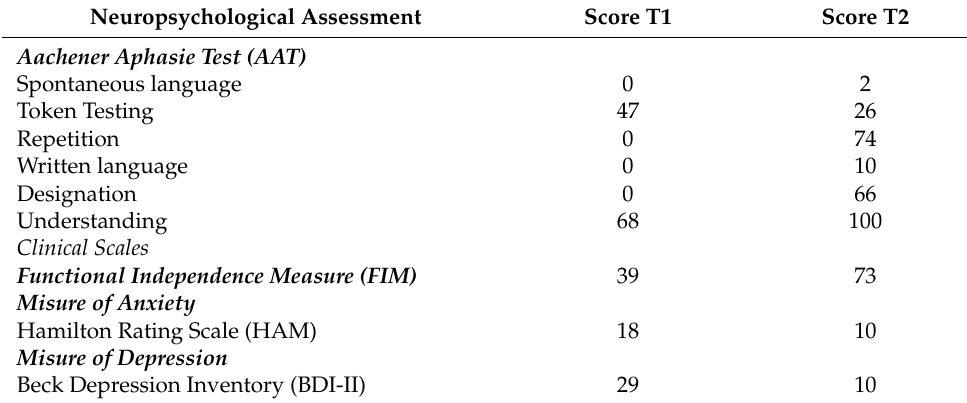
Table 1. Neuropsychological